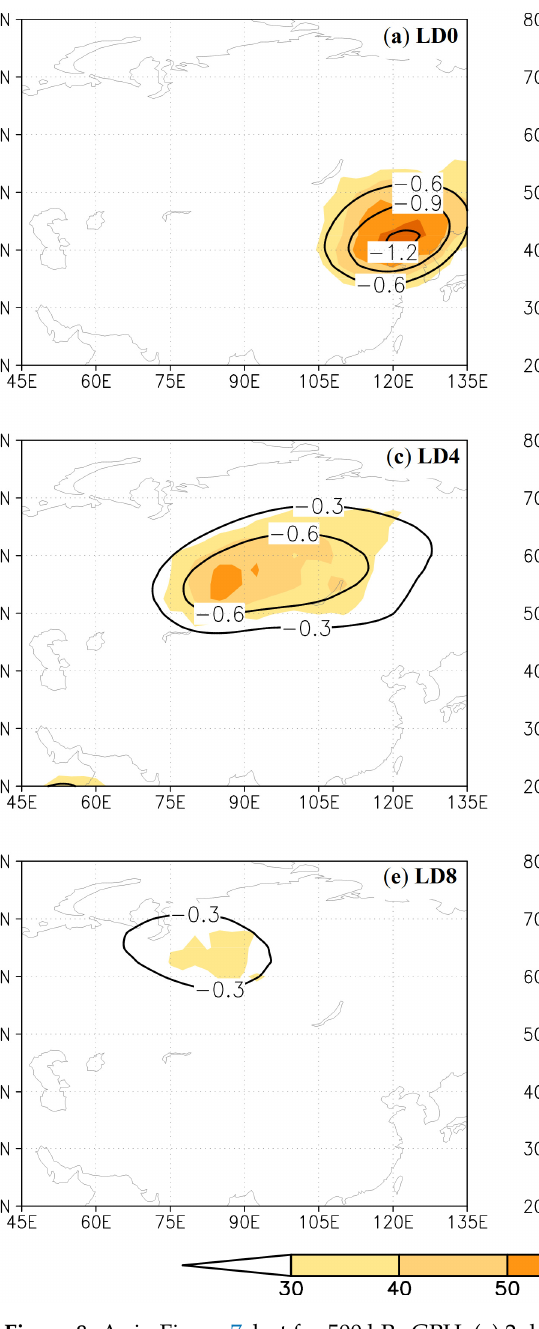
Figure 8. As in Figure 7, but for 500 hPa GPH. ( a ) 2 days ( b ), 4 days ( c ), 6 days ( d ), 8 days ( e ) and 10 days ( f ) prior to the occurrence at the competition zones of